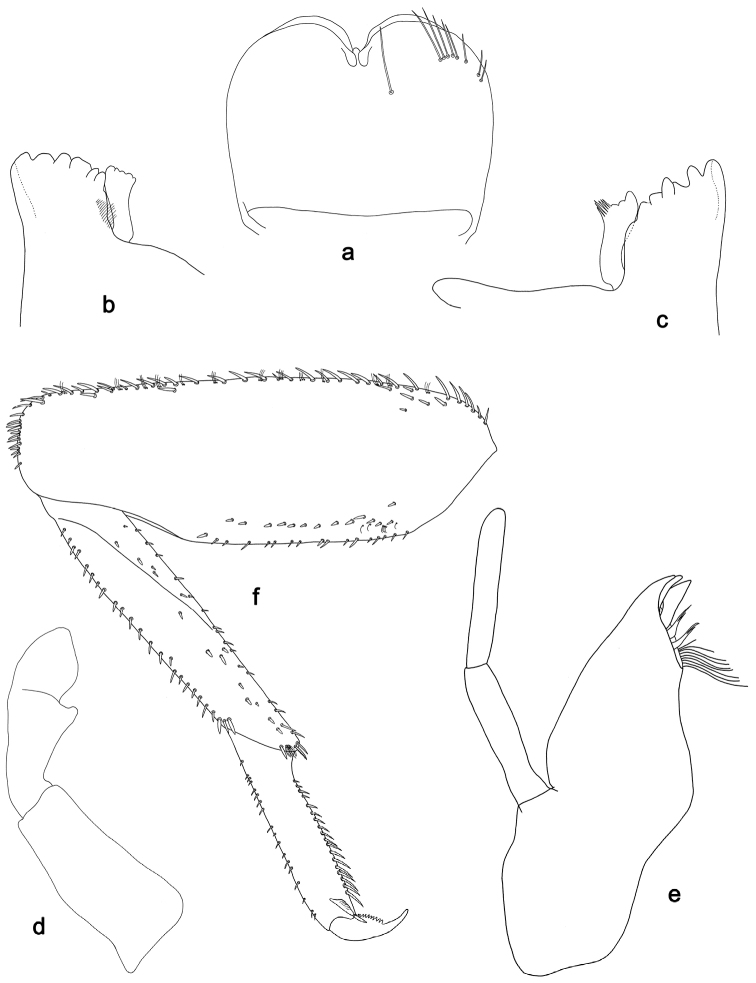
Labiobaetisvitilis, larva morphology: a Labrum b Right mandible c Left mandible d Labial palp e Maxilla fForeleg.